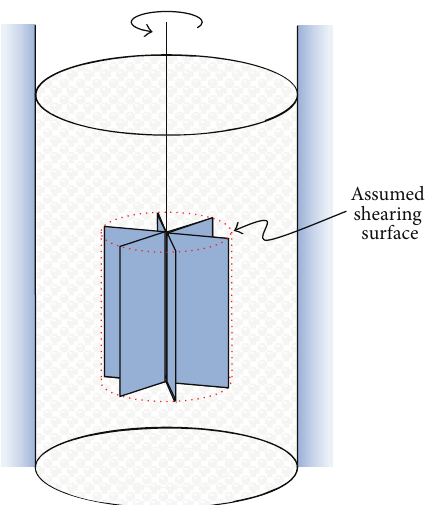
Figure 2: Schematic of one embodiment of a vane test. As per the dictum of Nguyen and Boger [90], the diameter and height of the sample are shown as (at least) double those of the vane here. The presumed shearing or slip “plane” is also